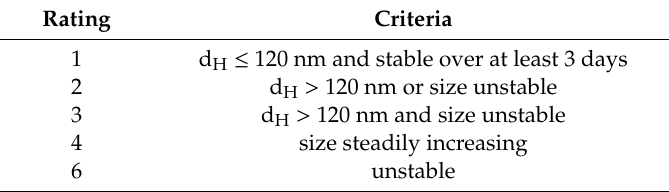
Table 1. Criteria for rating nanoparticle dispersion quality in the solvents used for analysis.